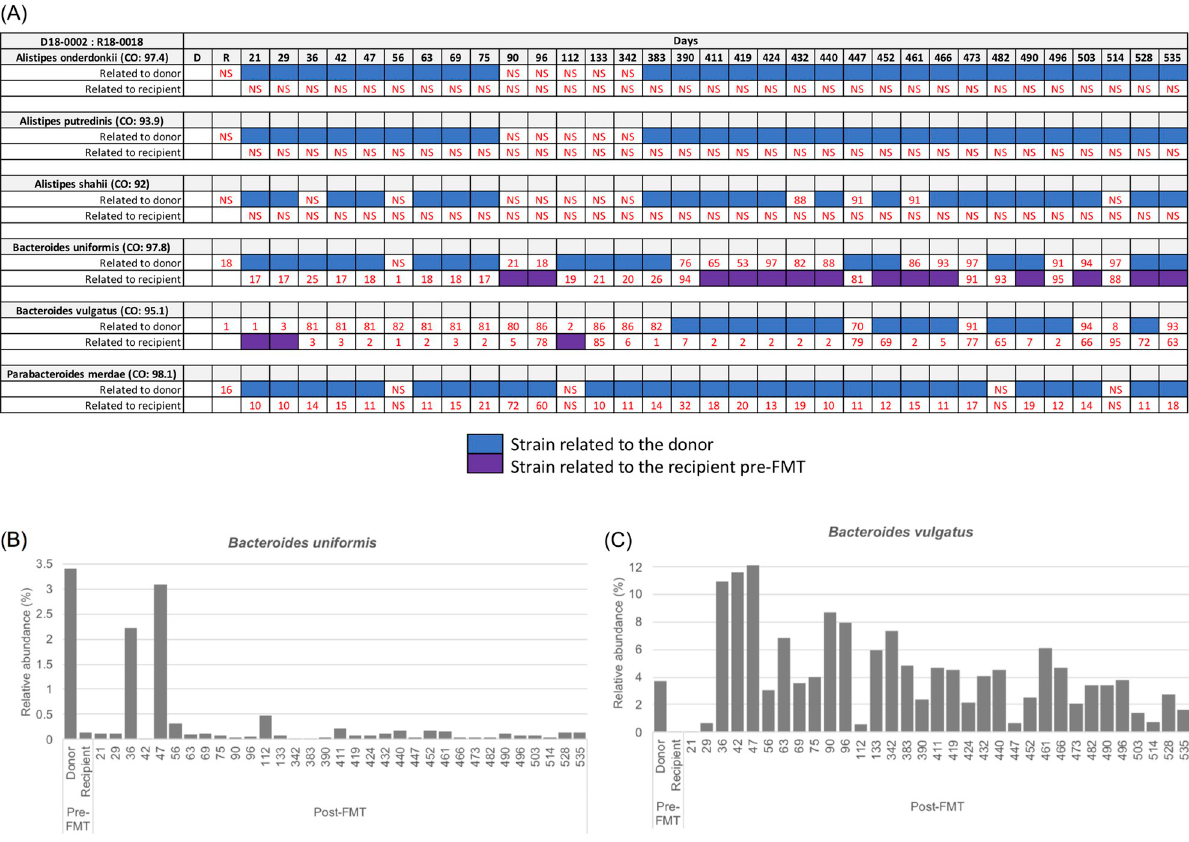
Fig 5. Summarized WSS scores with the taxonomic profile for the FMT donor 18-0002- recipient 18–0018 pair. (A) The WSS scores were determined by comparing 1) the donor’s sample to paired recipient’s pre- and post-FMT samples; and 2) the recipient’s pre-FMT sample to the same recipient’s post-FMT samples for donor 18–0002 and recipient 18–0018. Sample information for this pair was shown in S1 Table. The resultant WSS scores were grouped into different color boxes (see the figure key) or numerical numbers (when the score was below the cutoff value; NS = No Score). (B and C) Relative abundance was obtained for B . uniformis and B . vulgatus for this pair using MetaPhlAn2 analysis. For B . vulgatus , relative abundance for the Recipient was 0.03% and day 21 was 0.05%. For B . uniformis , relative abundance for the day 42 was 0.02% and day 342 was